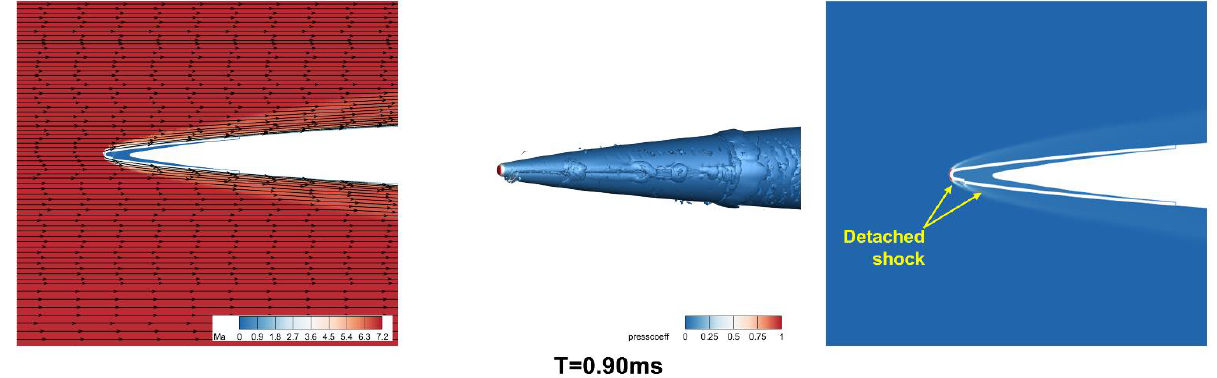
Figure 18. The contour of the streamline and Mach number ( left ), iso-surface of Q-criterion ( middle ), and the contour of the pressure coefficient ( right ) at T = 0.90 ms.